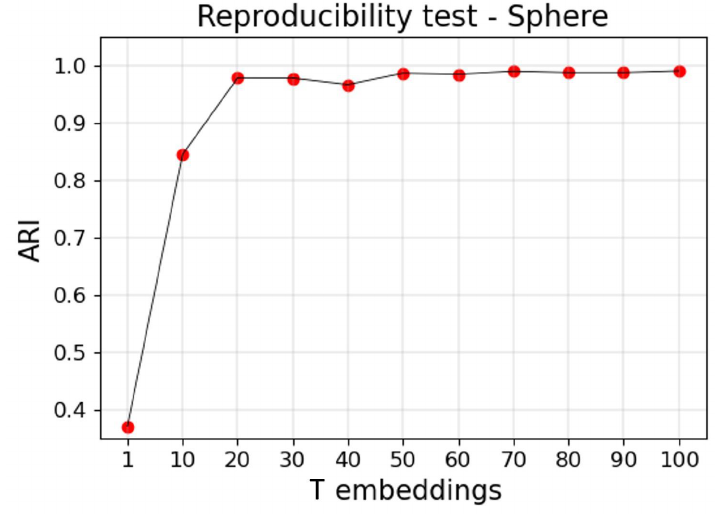
Figure A1. Reproducibility test. ARI scores between cluster labels obtained from two separate runs of T UMAP embeddings. With T = 1, the figure reports the ARI between two clustering outputs generated by HDBSCAN applied to two independent runs of UMAP. With T > 1, the ARI indicates the concordance between two clustering outputs generated by two separate runs of our proposed